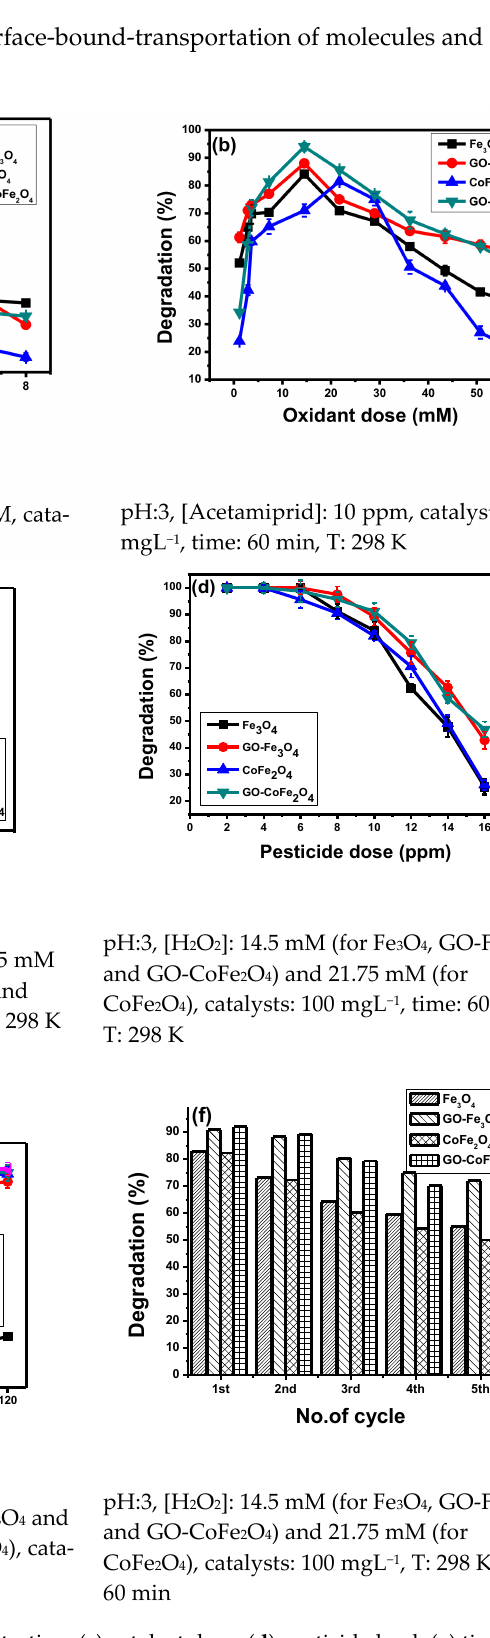
Figure 3. Optimization of ( a ) pH, ( b ) oxidant concentration, ( c ) catalyst dose, ( d ) pesticide load, ( e ) time of UV irradiation, and ( f ) reusability potential up to 5 consecutive runs against degradation of acetamiprid using Fe 3 O 4 , GO-Fe 3 O 4 , CoFe 2 O 4 , and GO-COFe 2 O 4 .